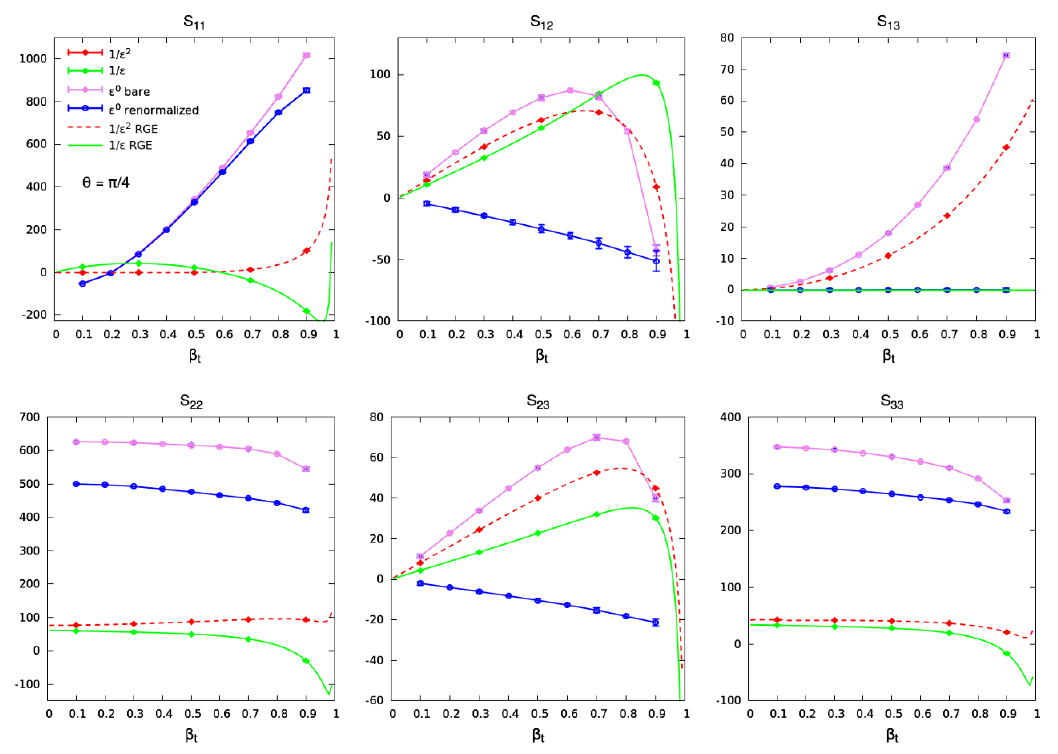
Figure 17 . Real part of the NNLO soft function in the gg channel. The (cid:12)gure shows six independent entries of the 3 (cid:2) 3 matrix. All details as in (cid:12)gure 16. (cid:12)gures 16 and 17, respectively. The points correspond to our direct calculation at orders 1 =(cid:15) 2 , 1 =(cid:15) and (cid:15) 0